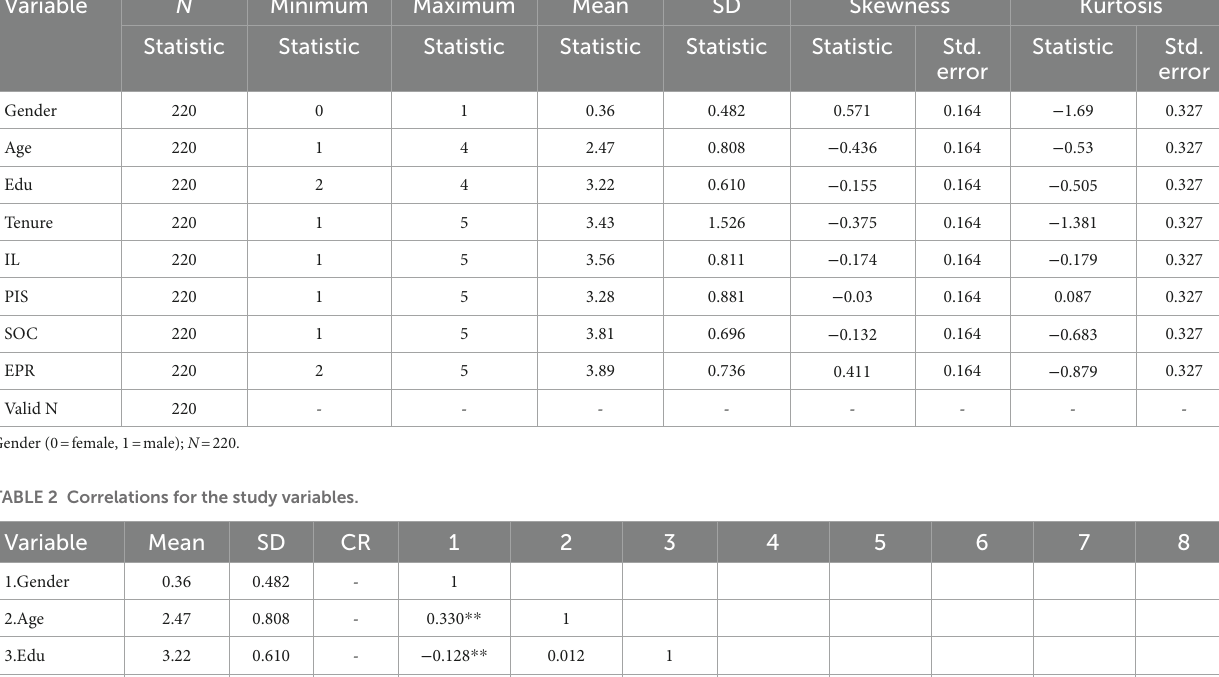
TABLE 1 Descriptive statistics.